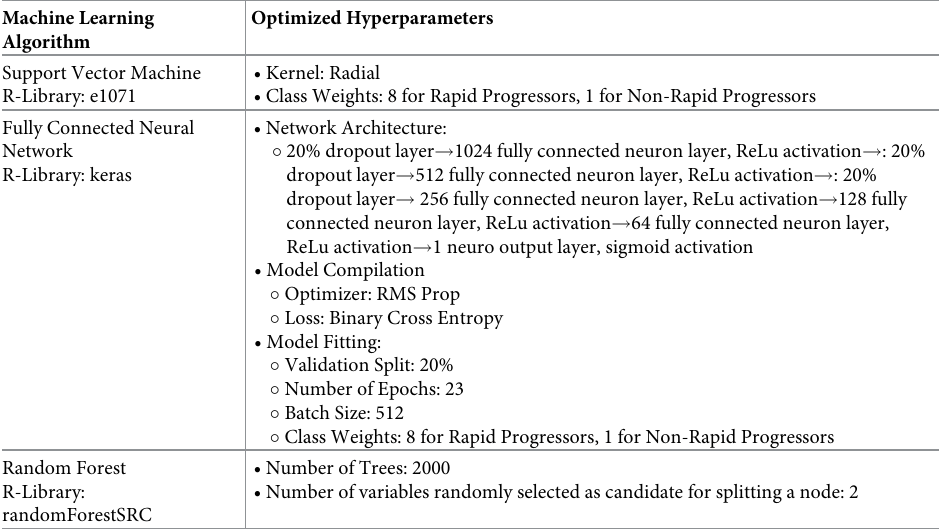
Table 1. Optimized hyperparameters used in various machine learning models.